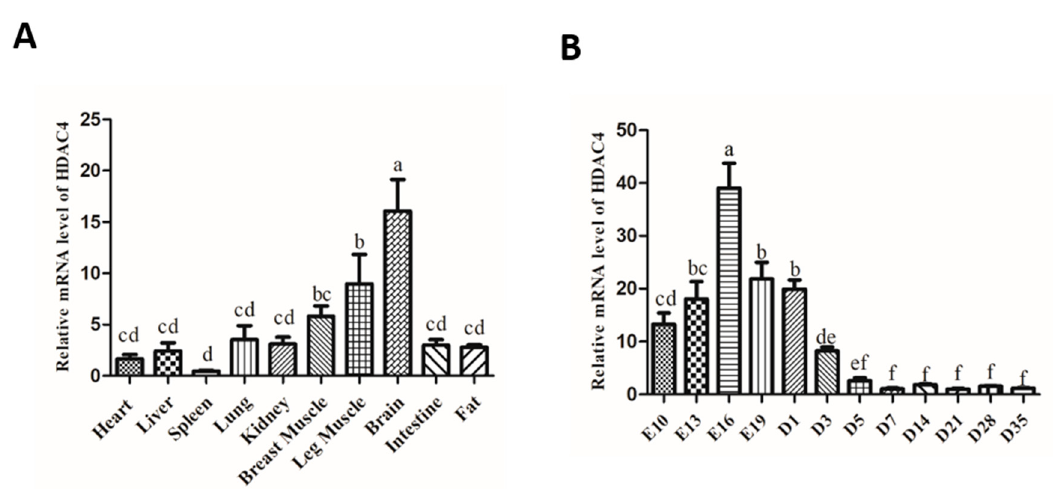
Figure 1. Expression pattern of HDAC4 gene in chickens. ( A ) The HDAC4 mRNA expression level was measured by qPCR in different tissues and organs of chicken. ( B ) The expression level of HDAC4 in breast muscle during E10 to D35 was detected by qPCR. In all panels, the values represent mean ± SEM from three independent experiments. a,b p < 0.05.